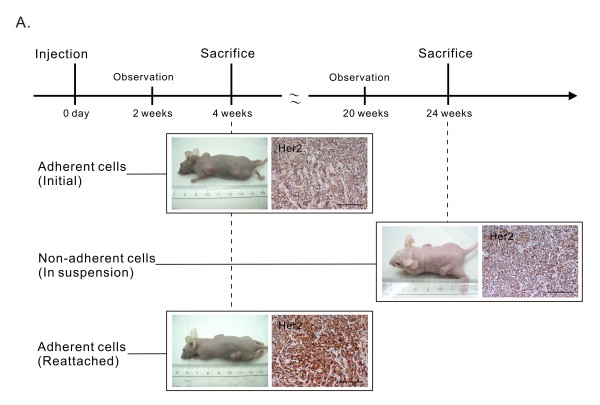
Tumorigenicity of 3 types of R2N1d cells in immune-deficient mice. Adherent (CD44+/CD24- sorted), non-adherent and re-attached R2N1d cells were inoculated subcutaneously into nude mice for tumor development. Only those mice inoculated with adherent and reattached R2N1d cells showed visible and palpable tumors 4 weeks after inoculation; Mice inoculated with non-adherent R2N1d cells developed tumors after 24 weeks. Histological sections of resected tumor harvested at 4 weeks (from adherent and reattached cells) or 24 weeks (from non-adherent cells) showed HER2 expression. The length of the scale bar of these photos is 100 μm.